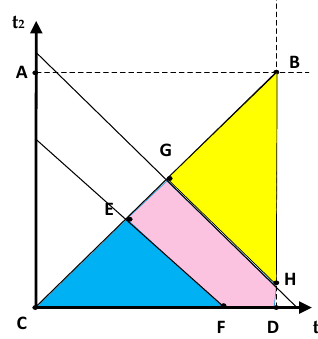
Figure 6. Influence of 𝑁𝑃𝑃 or 𝑁𝑃𝐺 on energy storage charge-discharge time decisions.